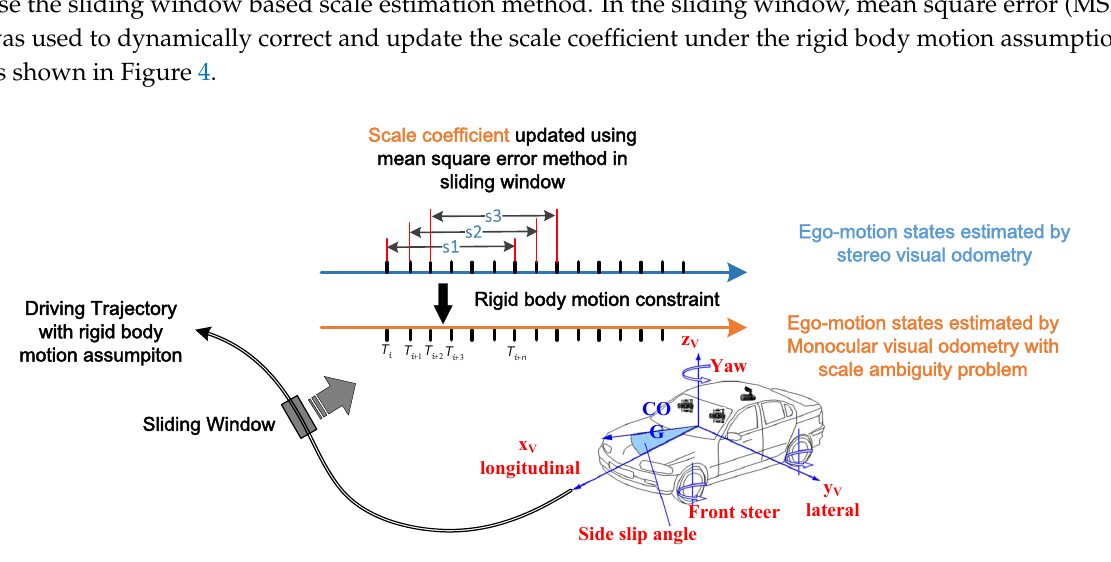
Figure 4. Sliding window based scale estimation of monocular visual odometry. [Color figure can be viewed at